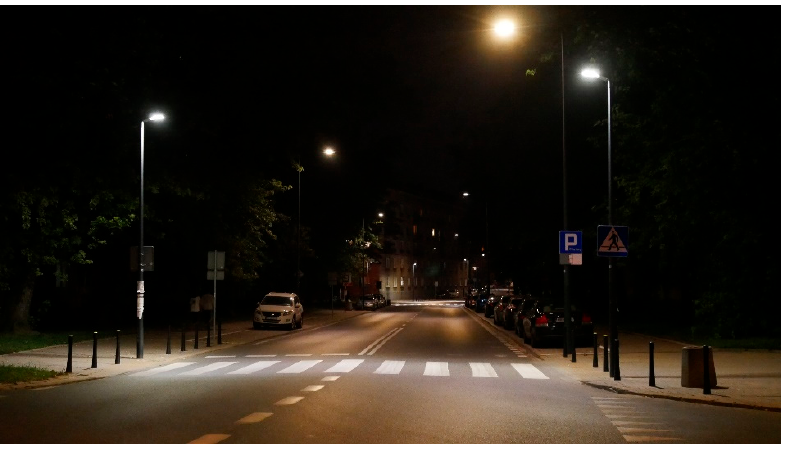
Figure 7. View of a representative section, Section 24.